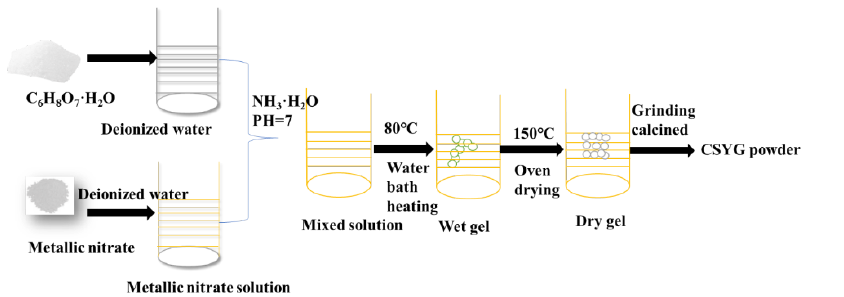
Figure 1. Flow chart of preparation of CSYG powders.